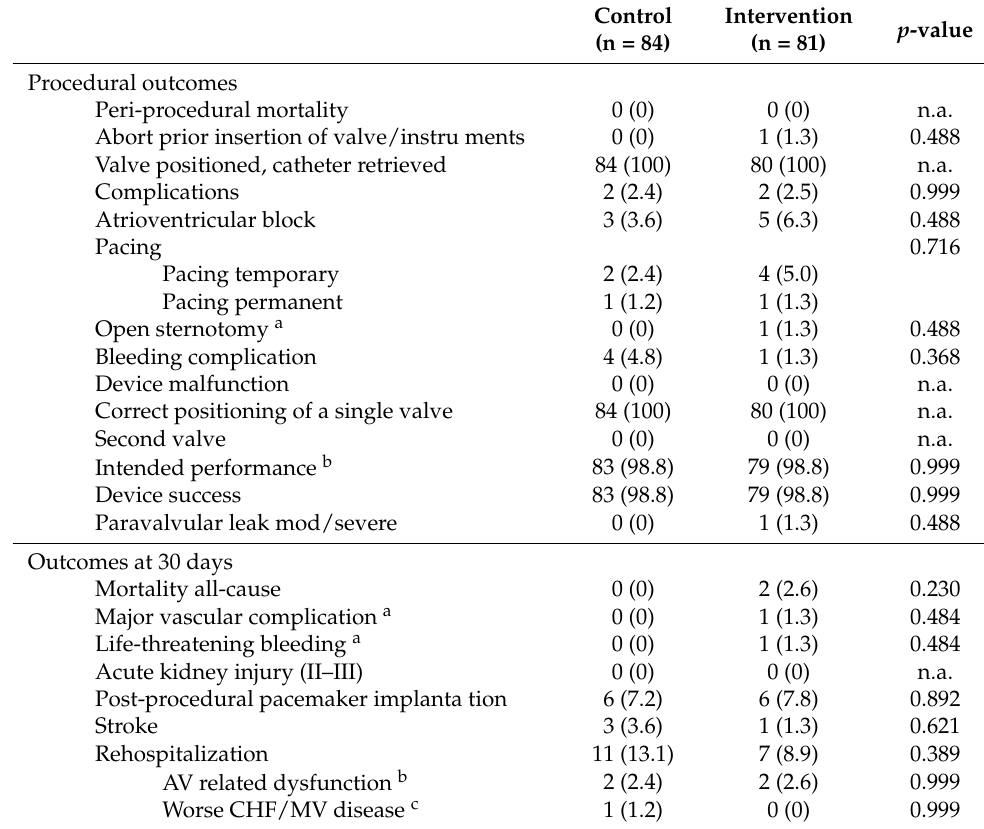
Table 5. Clinical outcomes post-procedure and at 30 days prior to (control phase) and after imple- mentation of the TAVI coordinator (intervention